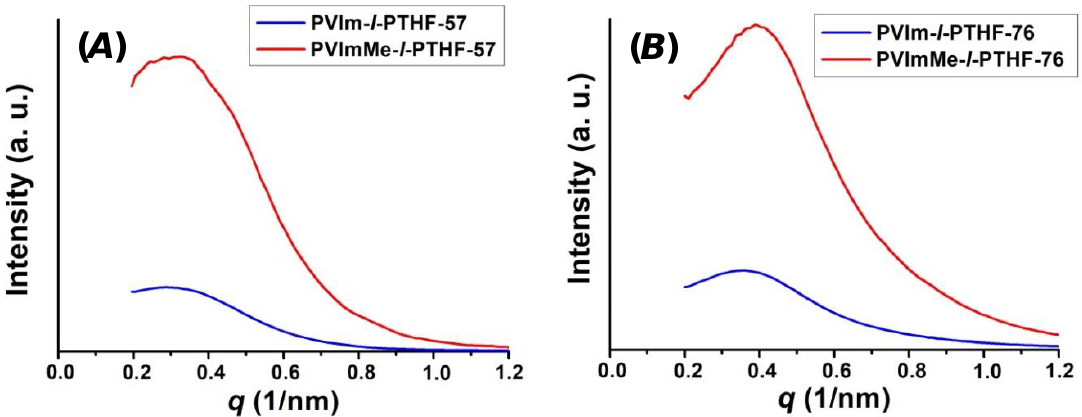
Figure 4. SAXS curves of the PVIm- l -PTHF-57 ( A ) and PVIm- l- PTHF-76 ( B ) (blue lines) and the methylated PVImMe- l -PTHF-57 ( A ) and PVImMe -l -PTHF-76 ( B ) poly(ionic liquid) (red lines) conetworks.